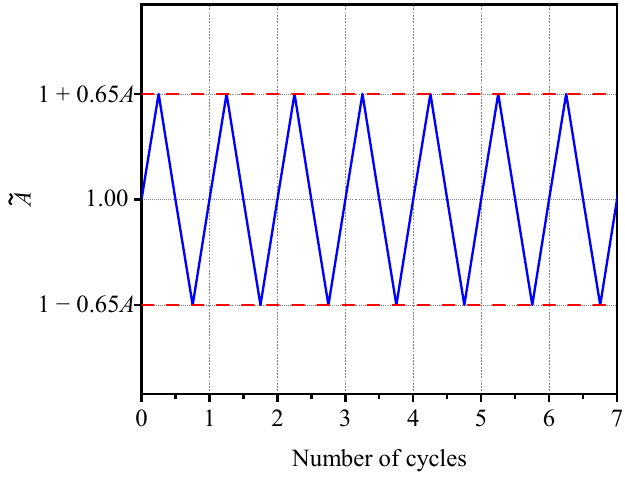
Figure 9. Cyclic load coefficient curve.